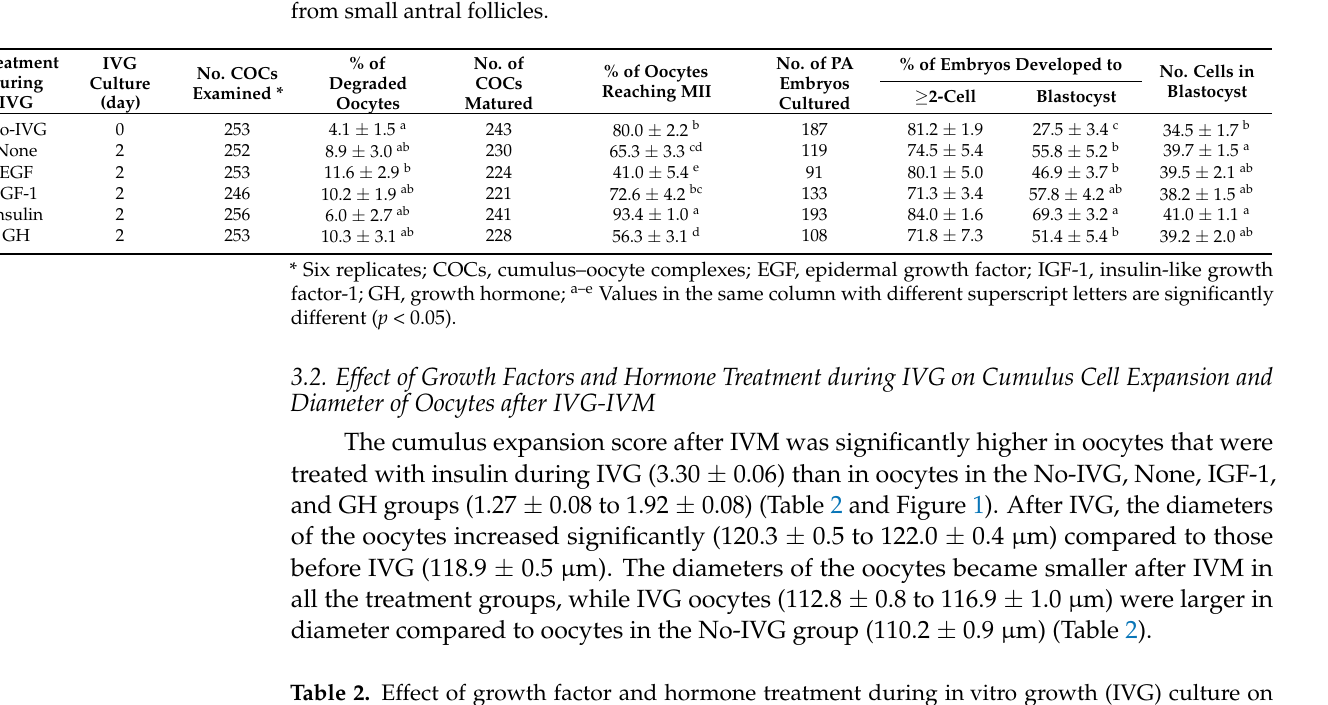
Table 2. Effect of growth factor and hormone treatment during in vitro growth (IVG) culture on cumulus cell expansion, diameter of oocytes, and size of the perivitelline space (PVS) after IVG and in vitro maturation